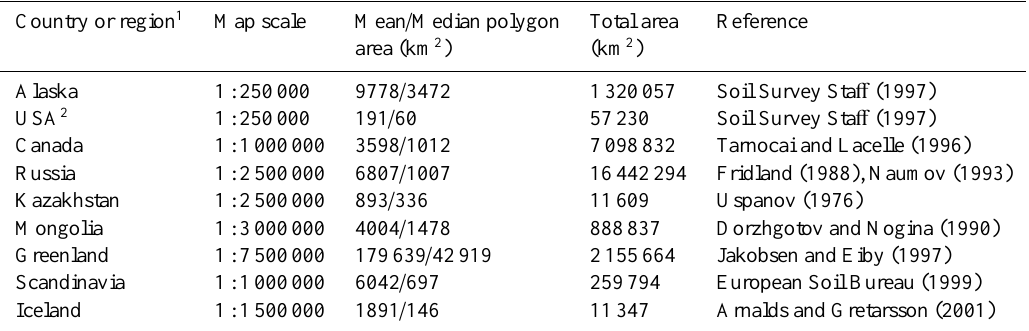
Table 4. General characteristics of the soil maps constituting the spatial base of the NCSCDv2. Note that the polygon mean and median areas refer to the polygons of the original digitized soil maps, prior to further subdivision in the NCSCDv2 due to permafrost zonation, etc. This table is complementary to Table 1 in Hugelius et al. (2013).